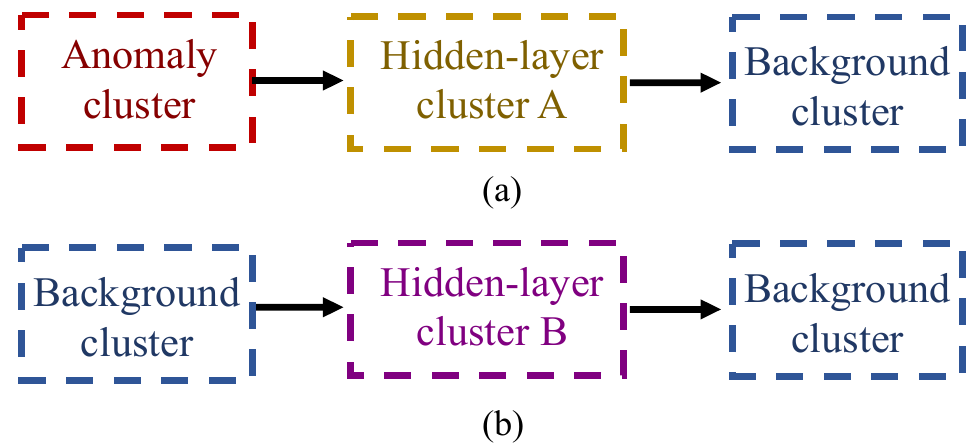
Figure 2. Reconstruction process of AE in hyperspectral data. ( a ) Reconstruction of anomaly. ( b ) Re- construction of background.